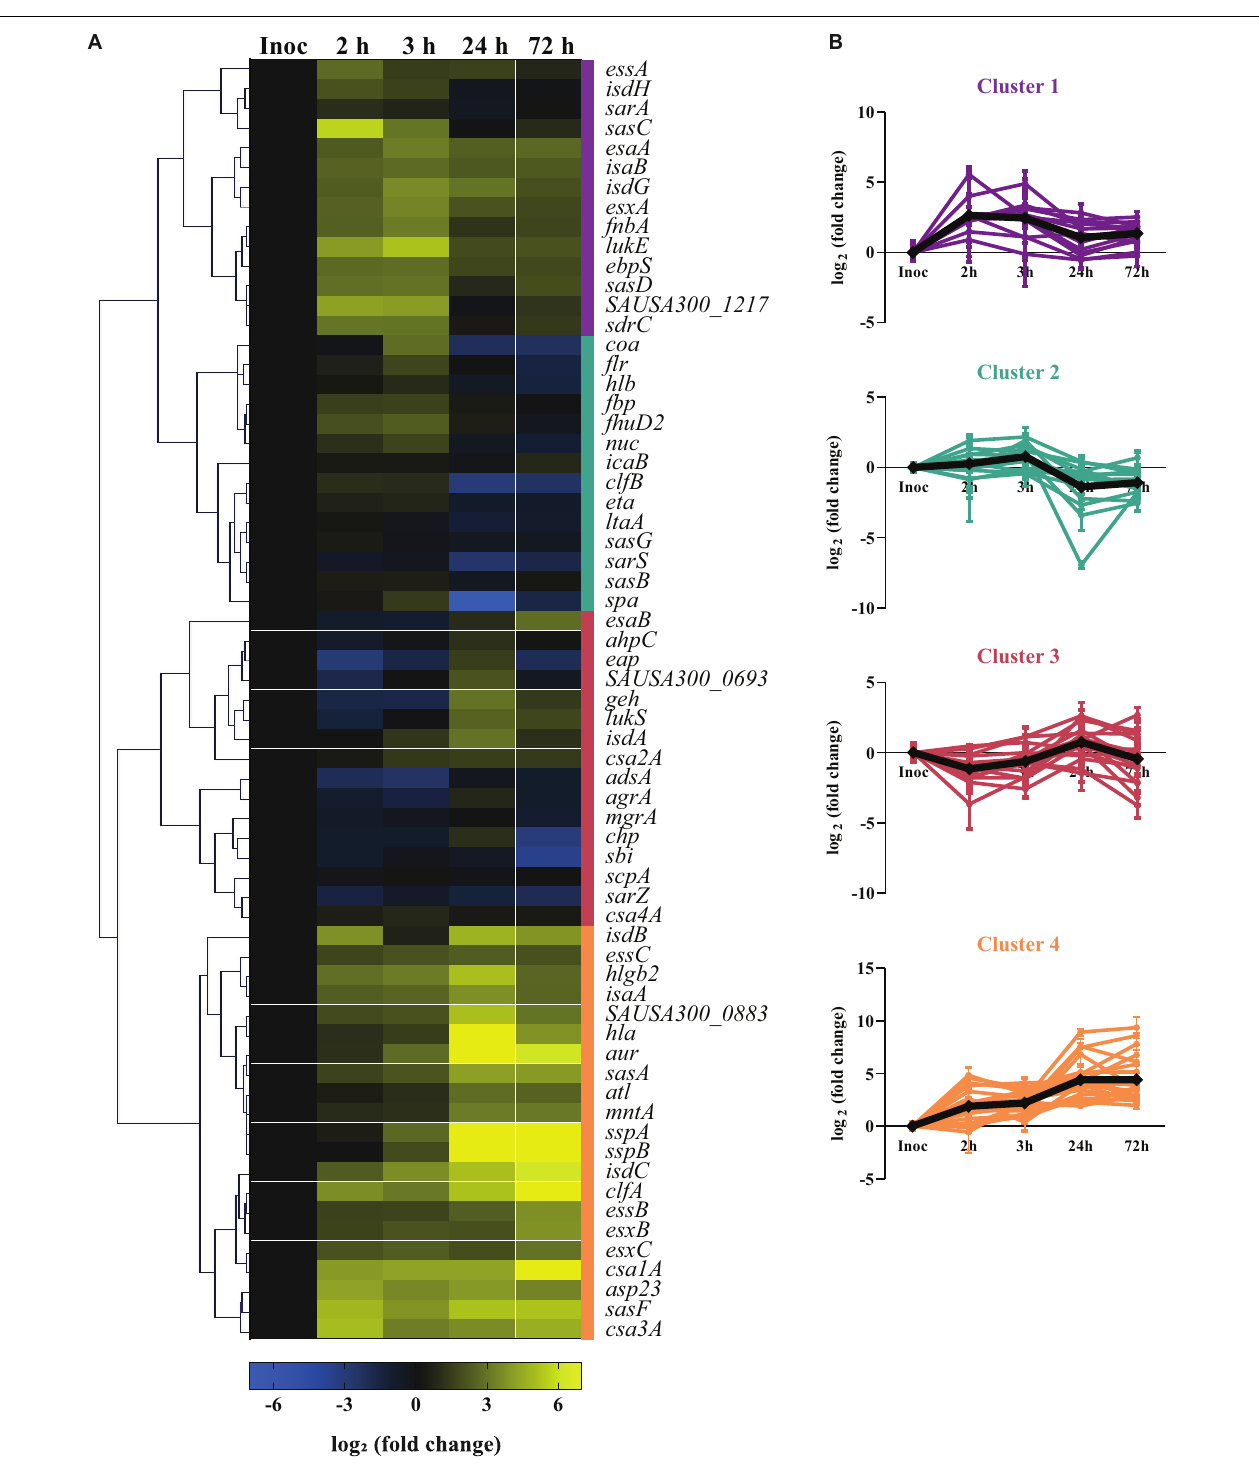
FIGURE 2 | Virulence gene expression kinetics of USA300 during infection of human skin explants. (A) Heatmap showing the transcription profile of 65 virulence factors of S. aureus during cutaneous infection. Values represent the mean of three independent experiments, normalized to the transcription levels of the inoculated bacteria (exponential phase, OD 600 = 0.6–0.7) and shown as log 2 (fold change). The genes that were less or more transcribed in the skin model than in the inoculated bacteria are depicted in blue or yellow, respectively. The colored bars on the right side of the heatmap represent the four major clusters: cluster 1 (purple), cluster 2 (green), cluster 3 (red), cluster 4 (orange). (B) Transcript level variation over infection of the virulence factors grouped within the same cluster. The black line represents the mean profile of the cluster genes.